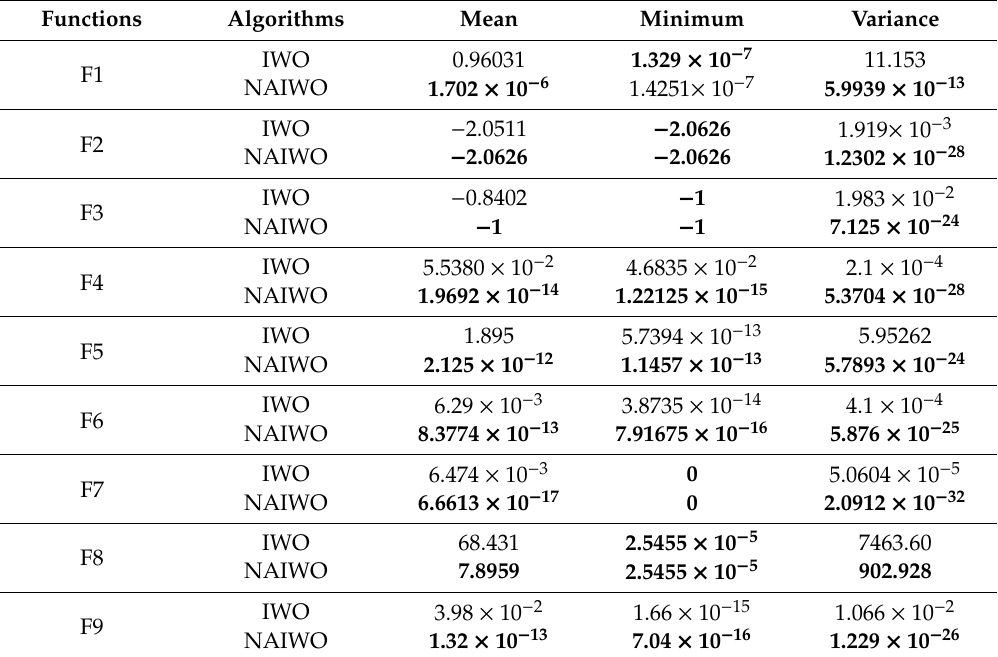
Table A2. Comparison data of IWO and NAIWO algorithms.